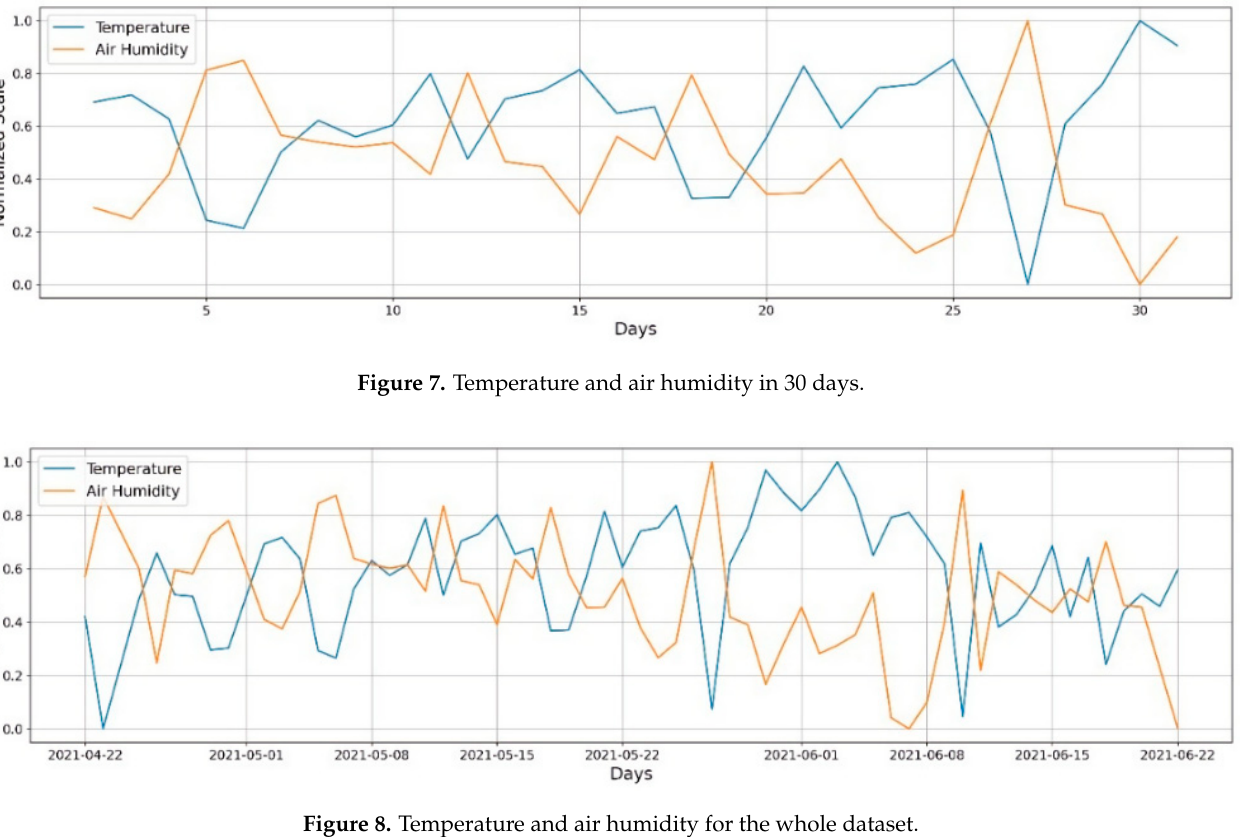
Figure 8. Temperature and air humidity for the whole dataset.